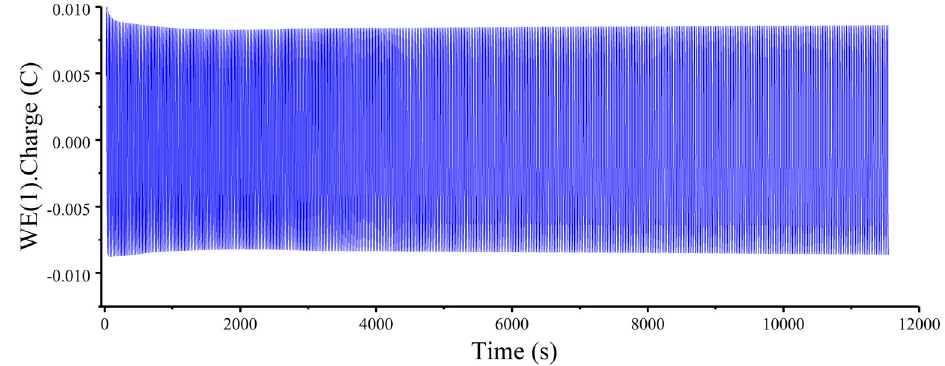
Figure 12: Dynamic change curve of